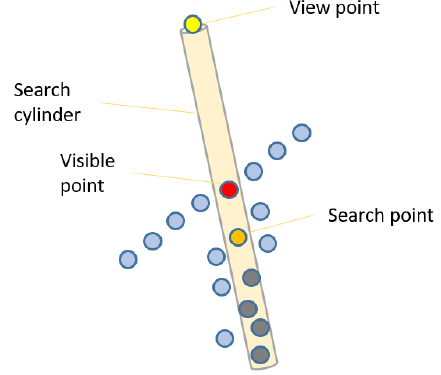
Figure 4. Hidden point removal